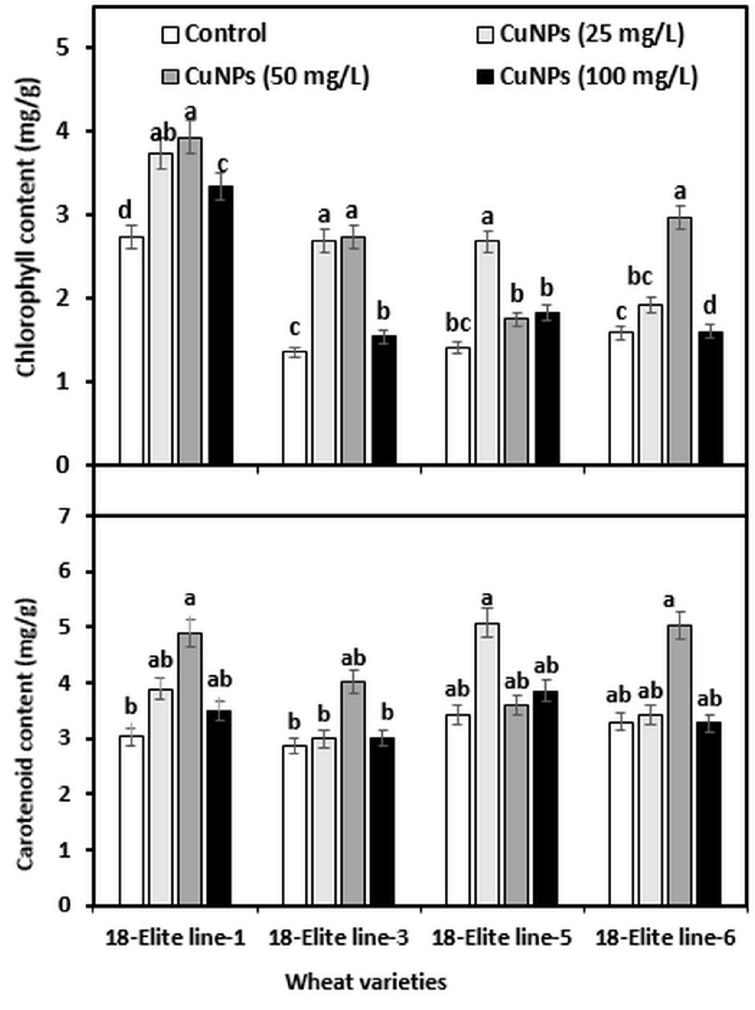
Fig 6. The total chlorophyll and carotenoid contents of 10 days wheat seedlings affected by different concentration of CuNPs. Different letters in the same sub-group of columns indicate significant difference at p < 0.05